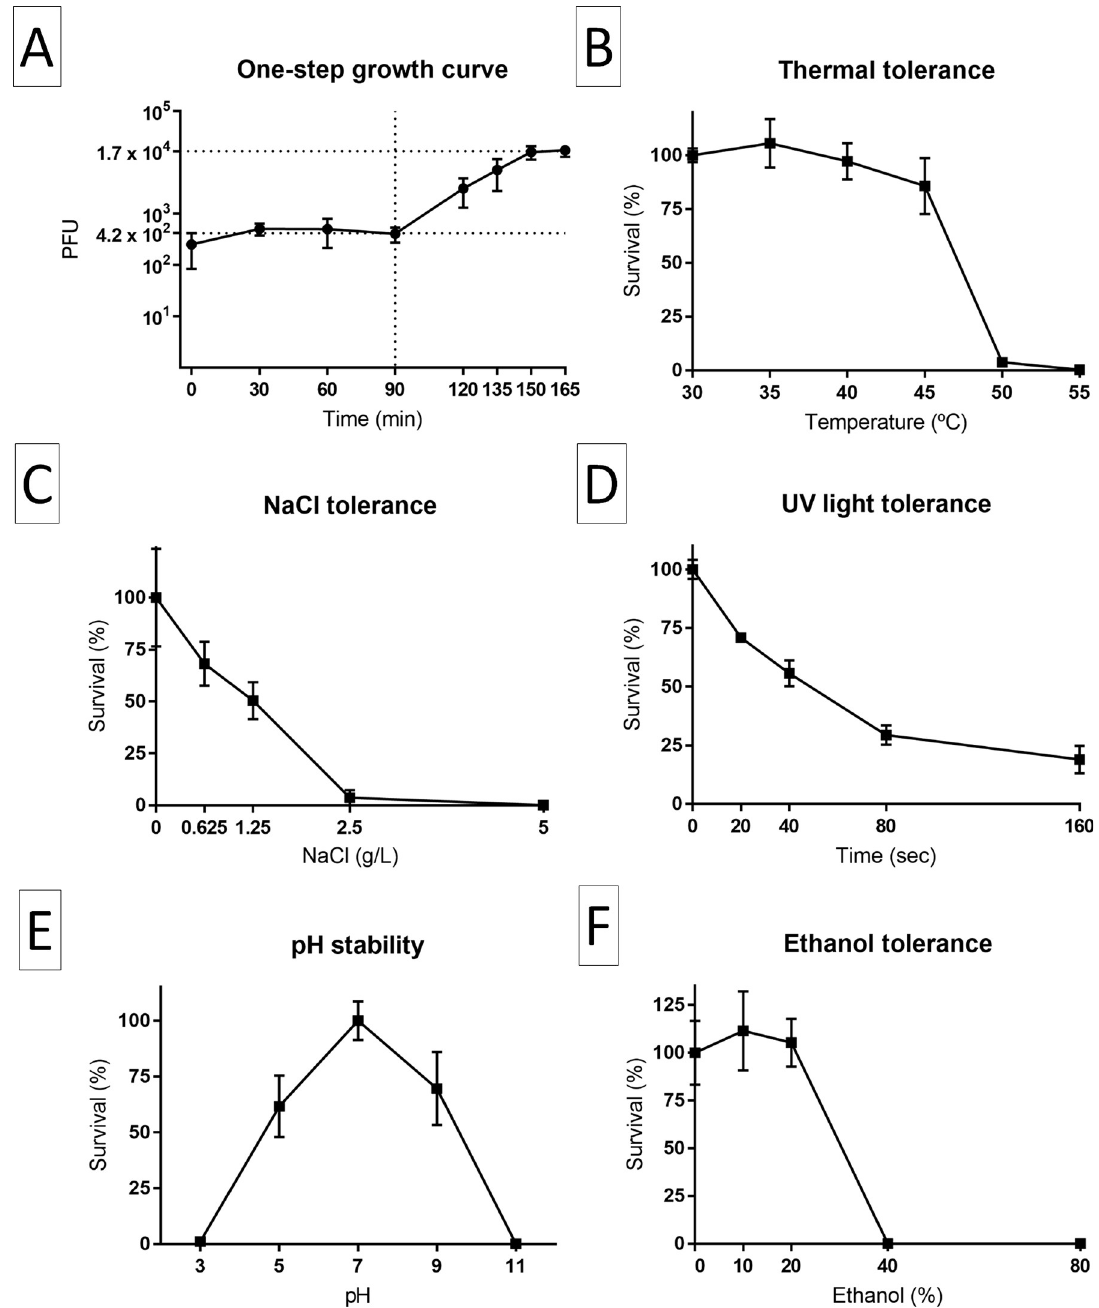
Fig 6. Growth and stability of vB_XciM_LucasX in Xac306. The phage had a latency period of approximately 90 min and a burst size of approximately 40 phages per infected cell of Xac306 (A) and remained viable up to 45˚C (B). However, its viability decreased with NaCl concentrations ranging from 0 to 2.5 g/L (C). Its viability also decreased when exposed to the UV light of a safety cabin for a few seconds (D). The optimum pH is 7 and its viability decreased to 60–70% when incubated at pH 5 and 9; it was completely inactivated at pH 3 and 11 (E). Finally, the phage remained stable in ethanol concentrations up to 20% but was inactivated in 40% ethanol (F). The graphs were produced using the software GraphPad Prism and the bars indicate the standard deviation of three replicates.